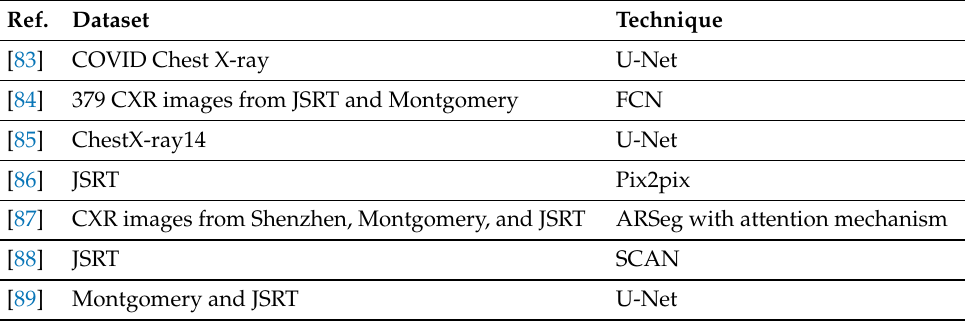
Table 5. Overview of different segmentation techniques for CXR images. Ref.